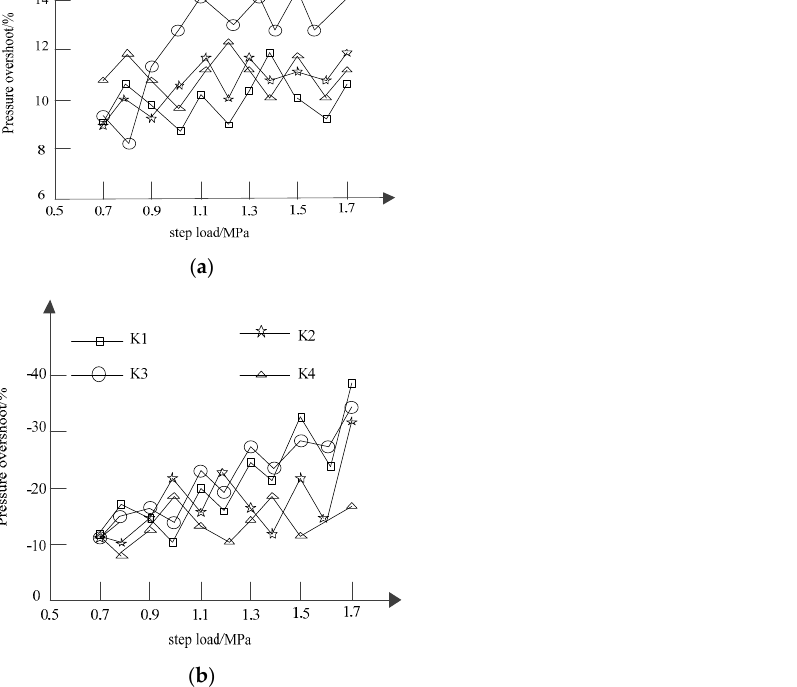
Figure 7. Variations of the overshoot of the rodless cavity pressure. ( a ) Loading of step load; ( b ) unloading of step load.